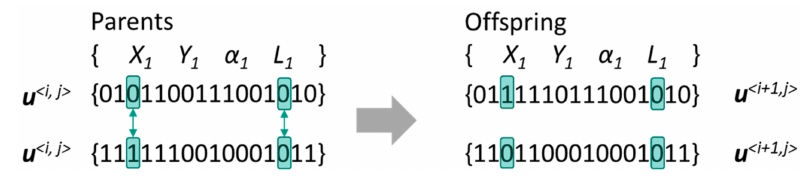
Figure 6. Workflow of the multi-point binary crossover for µ =